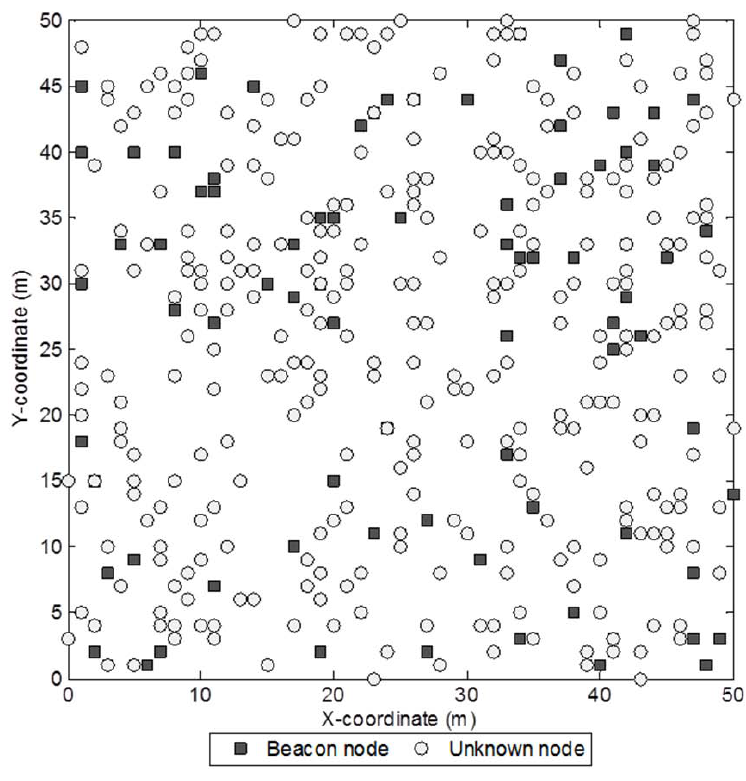
Figure 3. Sample network with 400 sensor nodes and a beacon ratio of